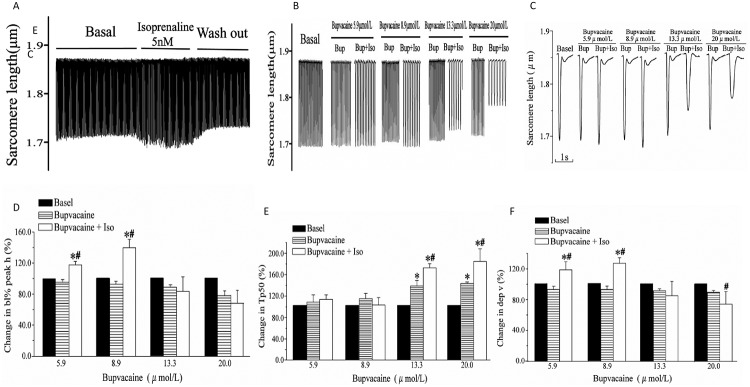
Effect of isoprenalin on bupivacaine-mediated depression of cardiomyocyte contractility.(A) Representative sarcomere-shortening trace before and after exposure to isoprenalin. (B) Representative sarcomere-shortening traces before and after exposure to bupivacaine with and without isoprenalin. Y axis: changing of sarcomere length during myocyte contraction; X axis: perfusates. (C) Representative individual signal of cardiomyocyte sarcomere shortening in the presence of bupivacaine, with and without 5.0 nmol/L isoprenalin. The signal was obtained by the averaging of ten successive signals. (D), (E) and (F) Statistical analysis of the effect of isoprenalin on bl% peak h, Tp50 and dep v in the presence of bupivacaine. Data are the mean ± SD. *P < 0.05, vs. basal value; †P < 0.05, vs. bupivacaine group.